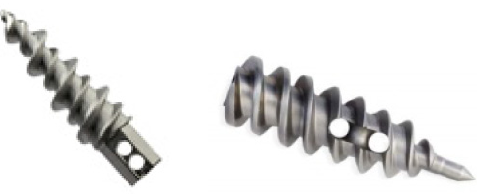
Figure 3. The TWINFIX designed devices. (See footprint selection on the text).